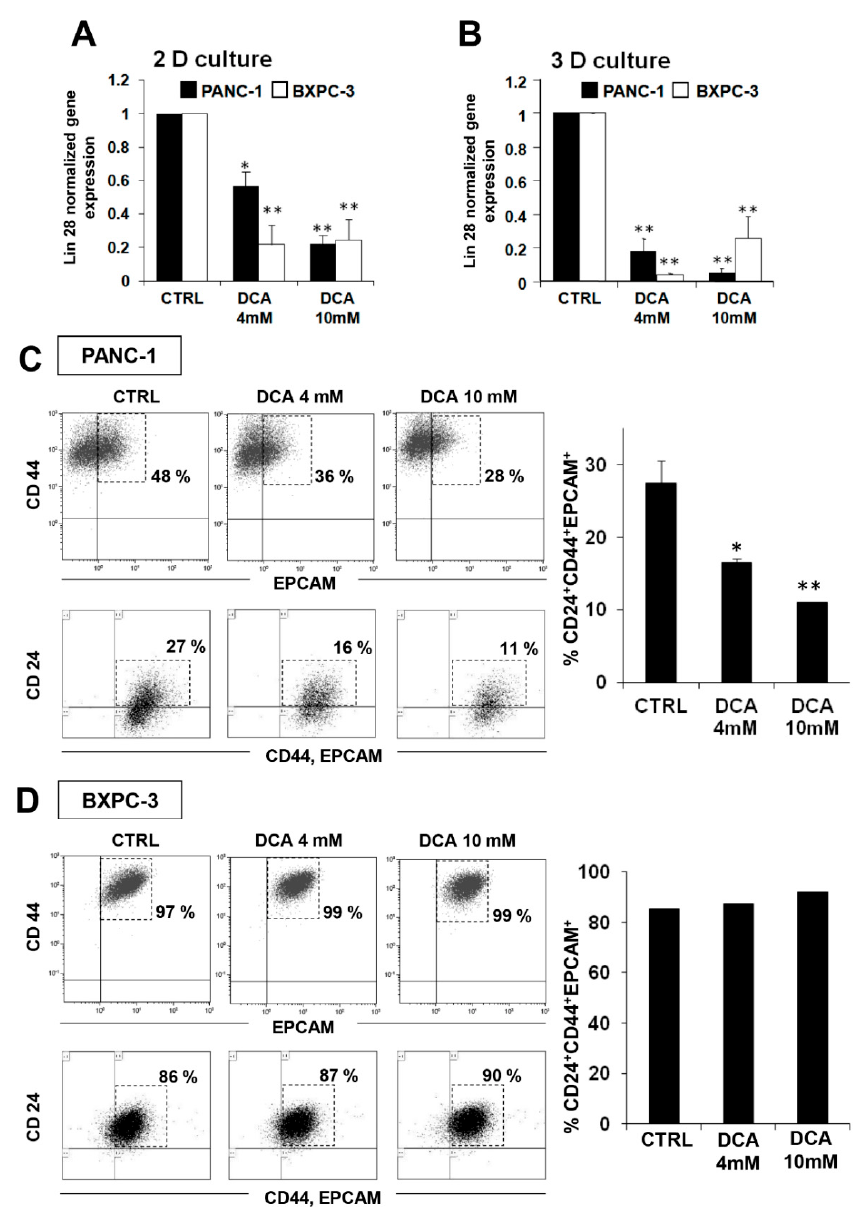
Figure 7. Effect of DCA on PANC-1 and BXPC-3 cancer stem cell markers, ( A ) quantitative RT-PCR analysis of Lin28 transcript performed in PANC-1 and BXPC-3 grown in monolayer for 24 h with DCA 4 mM and 10 mM, the values are the mean ± SEM of three independent experiments (* p < 0.05 vs. CTRL, ** p < 0.01 vs. CTRL); ( B ) quantitative RT-PCR analysis of Lin28 transcript performed in PANC-1 and BXPC-3 spheroids cultured for 7 days and treated with DCA for 72 h, the values are the mean ± SEM of three independent experiments (** p < 0.01 vs. CTRL); ( C ) representative dot plot analysis of CD44 (y axis) and EPCAM (x axis) expression in PANC-1 (upper tripartite panel) treated with DCA 4 mM and 10 mM for 24 h, the lower tripartite panel shows the corresponding expression of CD24 in CD44 + / EPCAM + cells; ( D ) representative dot plot analysis of CD44 (y axis) and EPCAM (x axis) expression in BXPC-3 (upper tripartite panel) treated with DCA 4 mM and 10 mM for 24 h, the lower tripartite panel shows the corresponding expression of CD24 in CD44 + / EPCAM + cells; the percentage in each dot plot of ( C ) and ( D ) of CD44 + / EPCAM + and CD24 + / CD44 + / EPCAM + cells is shown; the histograms on the right of ( C ) and ( D ) show the mean ± SEM of CD24 + / CD44 + / EPCAM + positive cells (expressed as percentage of total analyzed events) of at least three experiments; * p < 0.05, ** p < 0.01 vs.